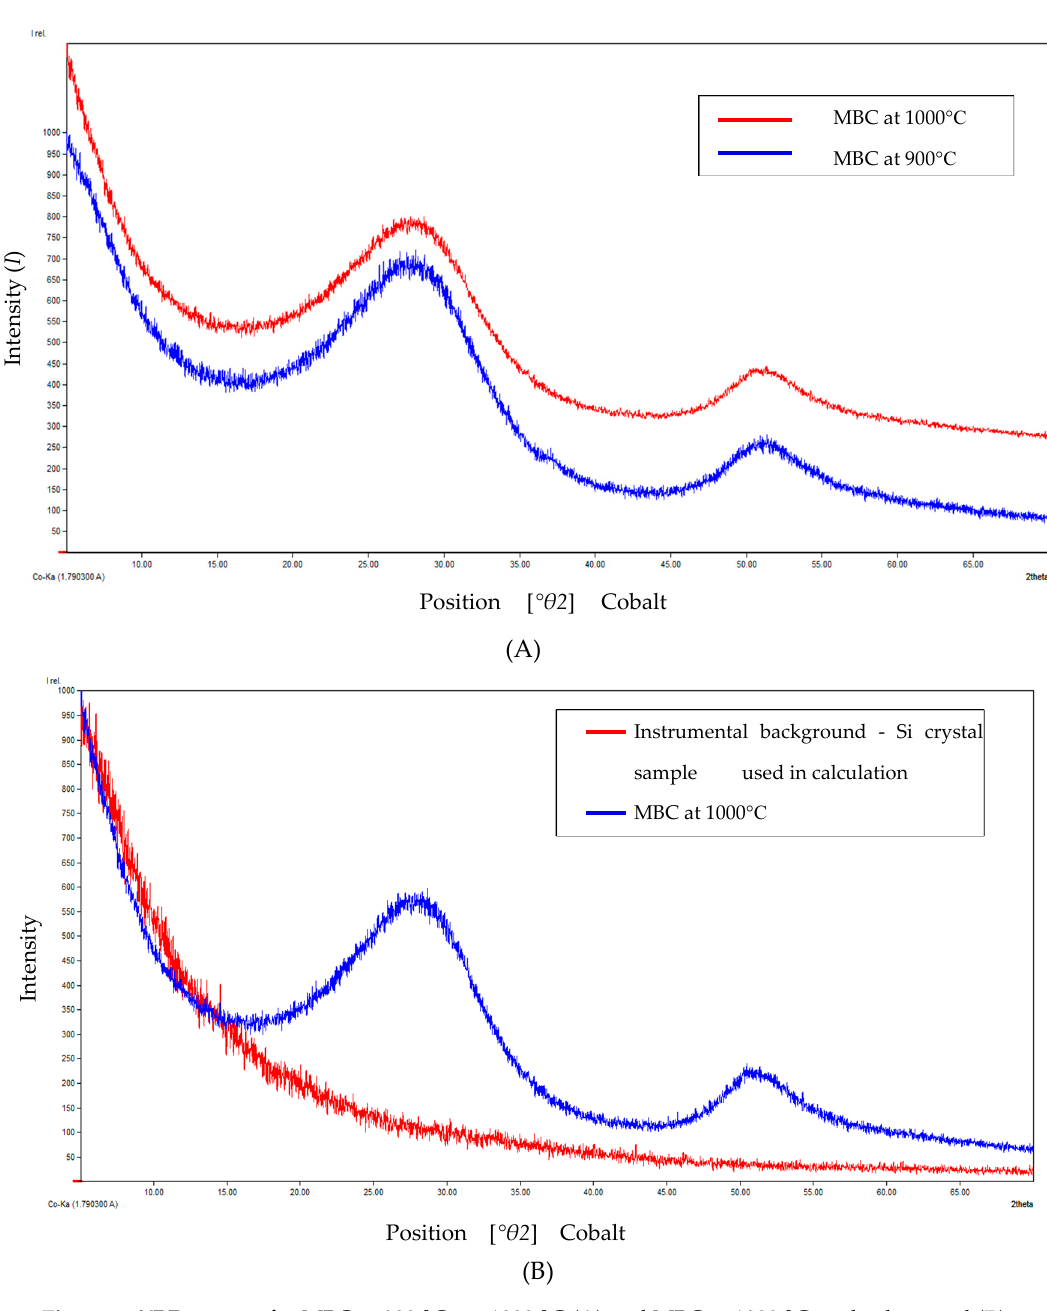
Figure 8. FTIR spectra of MBC prepared at 1000 °C before and after nitrate adsorption ( A ) and the second derivative FTIR spectra of MBC prepared at 1000 °C before and after nitrate adsorption ( B ).